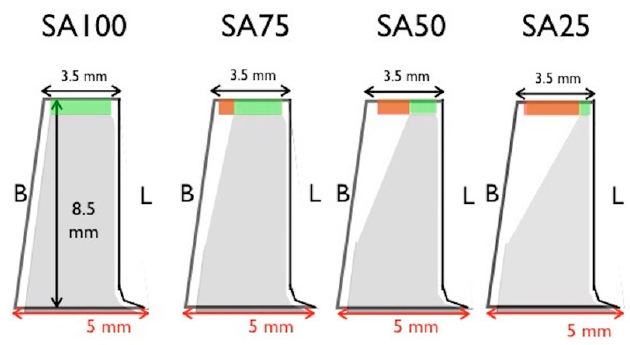
Figure 2. Schematic representation of the dimension of zirconia specimens on four implant abutments. B means buccal, L means lingual; Green color represents the occlusal surface area connecting the zirconia specimen and implant abutment. Brown color represents the implant abutment occlusal surface area reduction replaced with zirconia material .